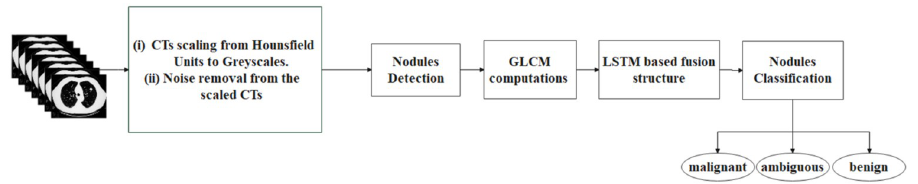
Fig 2. The constituent steps of the proposed